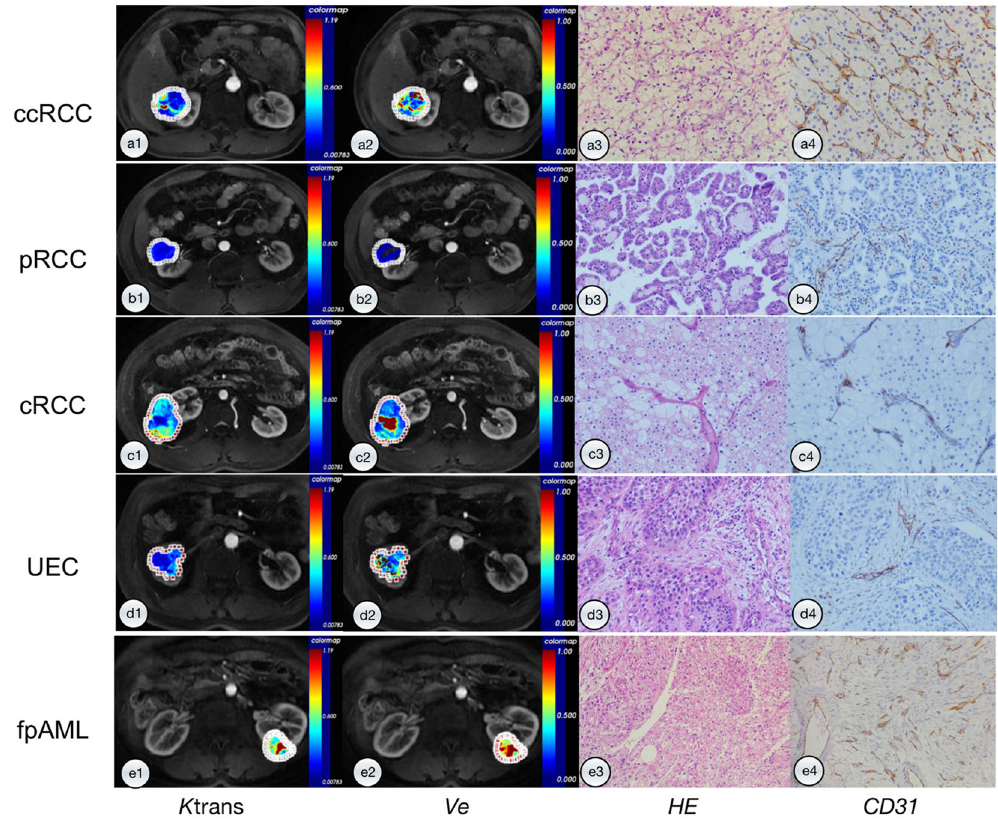
Figure 2. K trans , V e maps and photomicrographs of five renal tumor types. ( a ) A 46-year-old male with ccRCC. (a1) K trans value of ccRCC was 0.372 min − 1 ; (a2) V e value of ccRCC was 0.497; (a3) H&E staining (original magnification, 20 × ) shows solid alveolar and acinar patterns arranged by tumor cells with a clear cytoplasm and a regular network of small thin-walled blood vessels.; (a4) Immunohistochemistry for CD31 (original magnification, 20 × ) shows a network of small, thin-walled blood vessels. ( b ) A 45-year-old male with pRCC. (b1) K trans value of pRCC was 0.094 min − 1 ; (b2) V e value of pRCC was 0.213; (b3) H&E staining (original